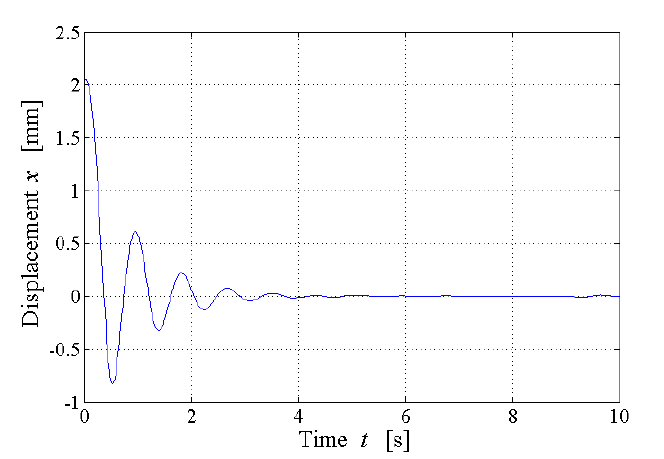
Figure 5. Simulation results of the repulsive magnetic suspension system.